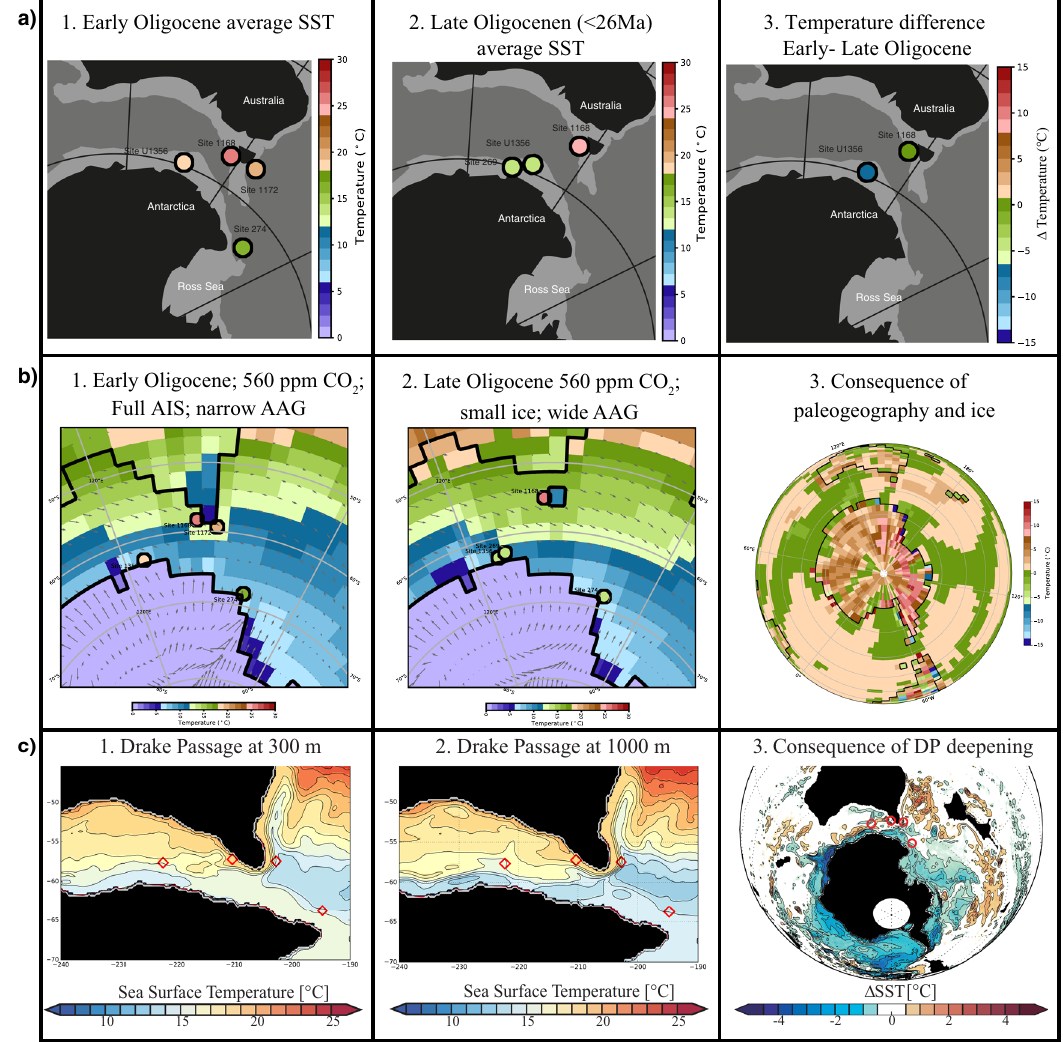
Fig. 3 Data-model experiment comparisons. a Paleogeographic map with SST data shown in colored dots from the respective drill sites. b Modeled SSTs from fully coupled HadCM3L simulations of the Early-(33.9 – 28.4 Ma) and Late Oligocene (28.4 – 23.0 Ma) 26 . The modeled simulations are TDLUQ and TDLUP respectively (see Supplementary Table 2). TDLUP SSTs are differenced from TDLUQ SSTs in the third panel. c High-resolution ocean model 25 . The Southern Ocean paleogeography is reconstructed for Late Eocene (38 Ma) for all three panels, red circles indicate the studied